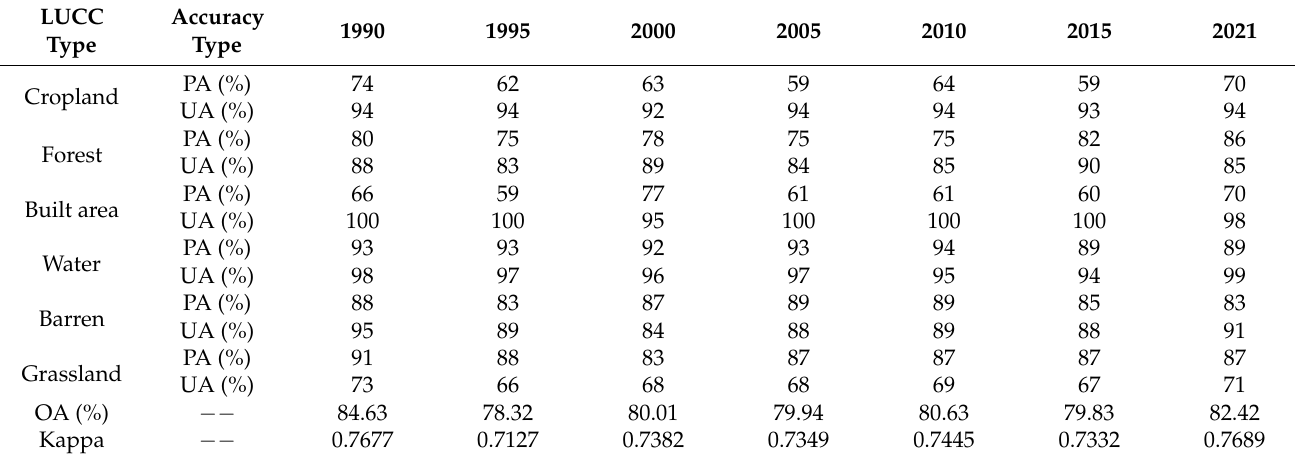
Table 4. Accuracy verification.